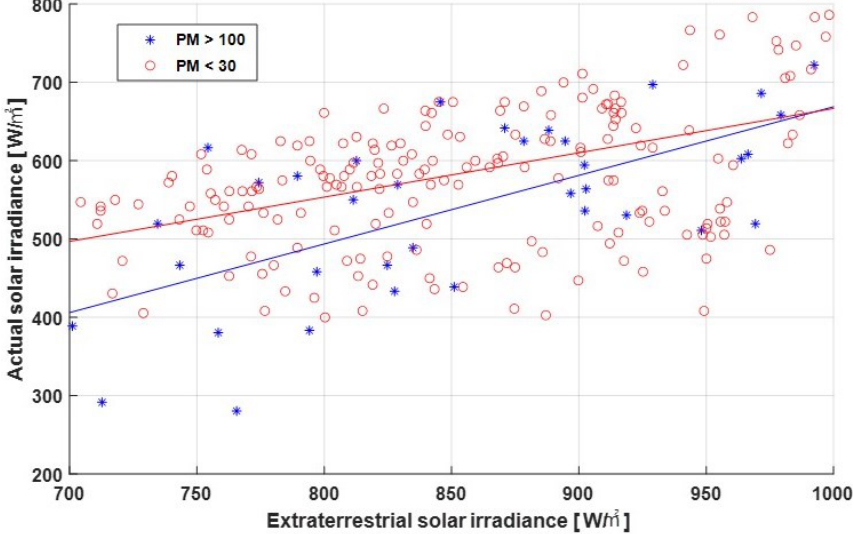
Figure 5. Scatter plot of extraterrestrial solar irradiation to actual solar irradiation in terms of the intensity of particulate